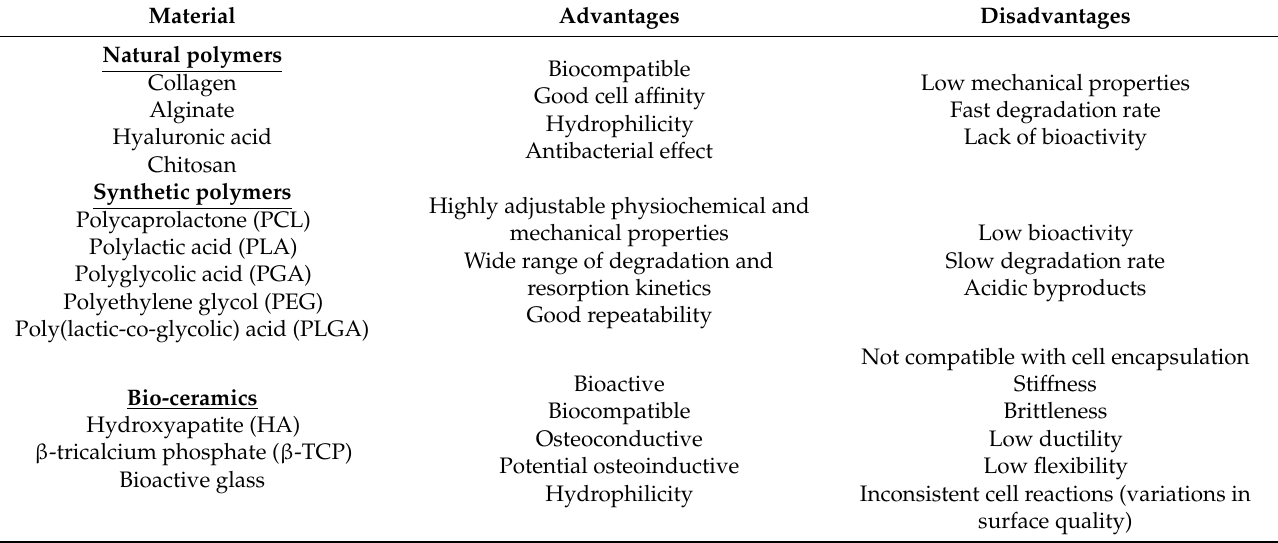
Table 1. Main biomaterials used in scaffold 3D